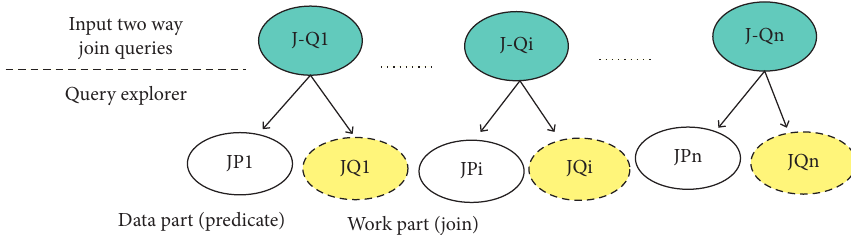
Figure 5: The exploring phase for two-way join